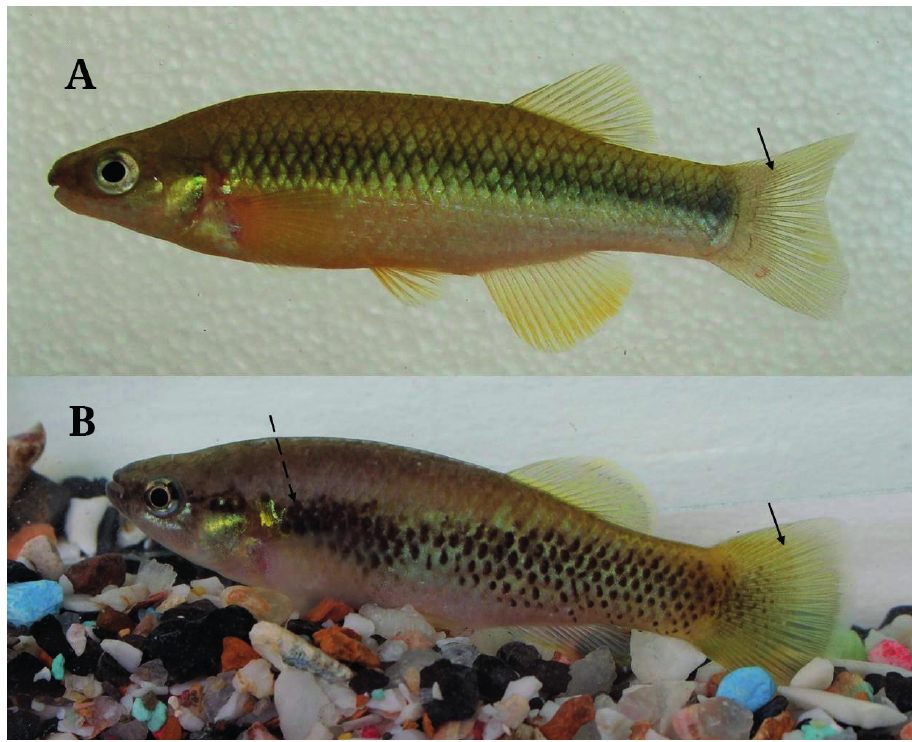
FIGURE 5 | Male general morphology and caudal fin squamation, life colour patterns in: A. Tlaloc labialis ; and B. Profundulus punctatus . Solid arrow points to the squamation of the caudal fin, dashed arrow points to the humeral